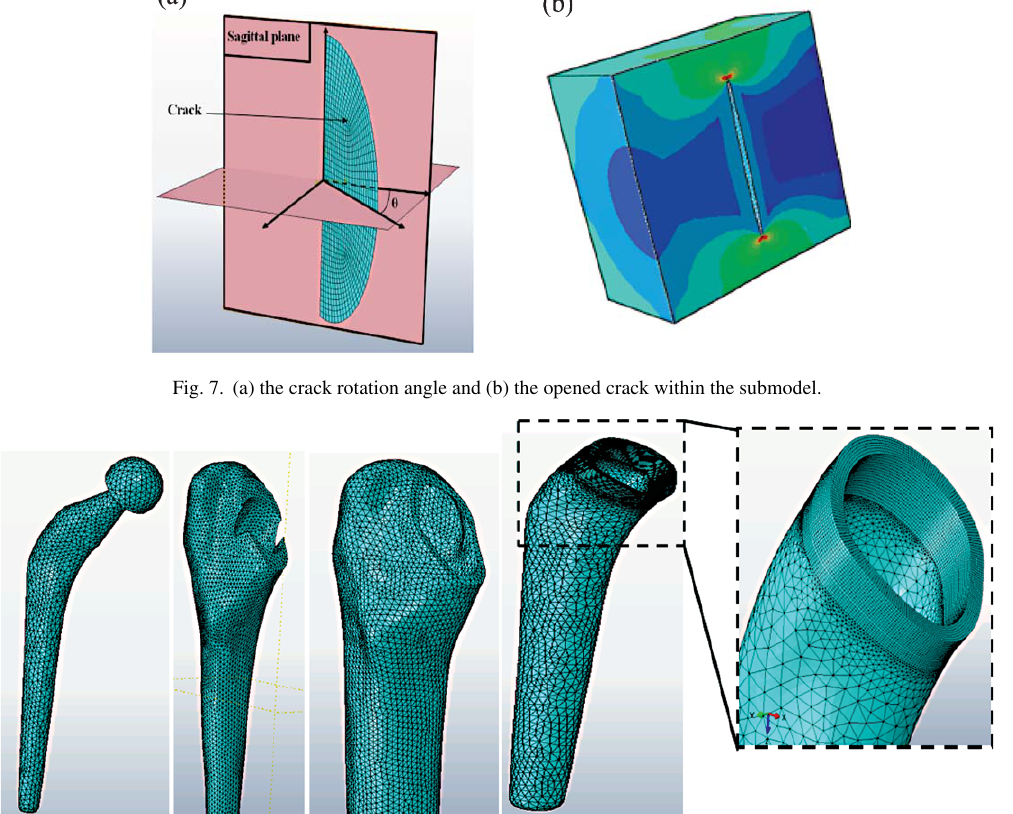
Fig. 8. Mesh of the different parts of the THR with refined meshing of the proximal region of the